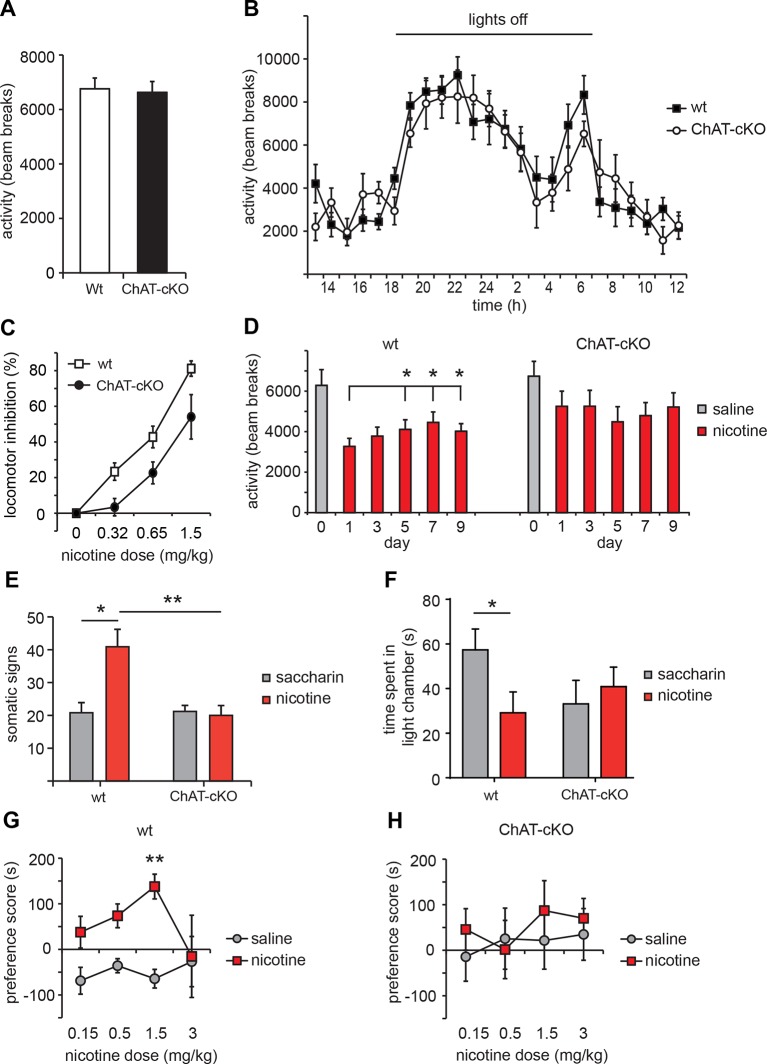
ChAT-cKO mice are insensitive to nicotine-conditioned reward and show no signs of nicotine withdrawal.(A) Basal activity, measured as locomotion in a novel environment is similar in ChAT-cKO and wt mice (n = 9 per genotype). (B) Day/night locomotor activity measured as number of beam breaks in 1 hr intervals for 72 hr (averaged to 24 hr) was unchanged in ChAT-cKO (n = 6) compared to wt mice (n = 10). (C) Dose-response of acute effects of nicotine injections on hypolocomotor activity. Nicotine i.p. challenges produced significantly more hypoactivity in wt mice compared to ChAT-cKO mice across all nicotine doses tested (n = 8–10 per genotype and dose; two–way ANOVA for genotype: p<0.001). (D) Daily i.p. injection of 0.65 mg/kg nicotine induced tolerance behavior in wt but not in ChAT-cKO mice: hypolocomotion was significantly attenuated in wt after 5 days of treatment compared to the first day of administration (n=6 per genotype, one–way-ANOVA days 1–9: wt F(2.446) = 4.963, p<0.05 and ChAT-cKO F(1,548) = 0.988, n.s.; paired t-test *p<0.05) but ChAT-cKO maintained similar locomotor activity at consecutive days of nicotine treatment. (E-F) Nicotine withdrawal was measured by quantification of (E) somatic signs (including scratching, rearing, head nods, body shakes and grooming) and (F) anxiety-like behavior (as time spent in dark versus light chamber). Signs of nicotine withdrawal were measured in mice drinking saccharin-sweetened water (somatic tests: n=5 per genotype, affective tests: n=8 for wt and n=14 for cKO) or saccharin-sweetened water containing nicotine (somatic tests: n=11 for wt, n=9 for ChAT-cKO; affective: n=11 for wt, n=13 for cKO) for 6 weeks. Precipitation of withdrawal by injection of the nicotinic antagonist mecamylamine elicited somatic and affective signs of withdrawal in wt mice treated with nicotine compared to the saccharin-treated mice (unpaired t-test: *p < 0.05). ChAT-cKO mice treated with saccharin spent less time in the light camber than wt mice treated with saccharin, but this difference was not statistically significant (unpaired t-test; p=0,14). ChAT-cKO mice showed no significant signs of either somatic or affective nicotine withdrawal since there were no differences between the nicotine and control groups (unpaired t-test: **p < 0.01, *p<0.05). (G,H) Nicotine place preference was measured by pairing nicotine or saline injections to different chambers for 3 consecutive days and measuring the time spent in either chamber on the test day. Wt (G) but not ChAT-cKO (H) mice showed robust conditioned place preference after pairing the environment with 1.5 mg/kg nicotine. Each point represents the mean ± S.E.M. of 6–10 mice per group (paired t-test: nicotine vs. saline compartment, **p<0.01; two–way matched ANOVA for substance: **p=0.007 in wt). cKO: Conditional knockout.